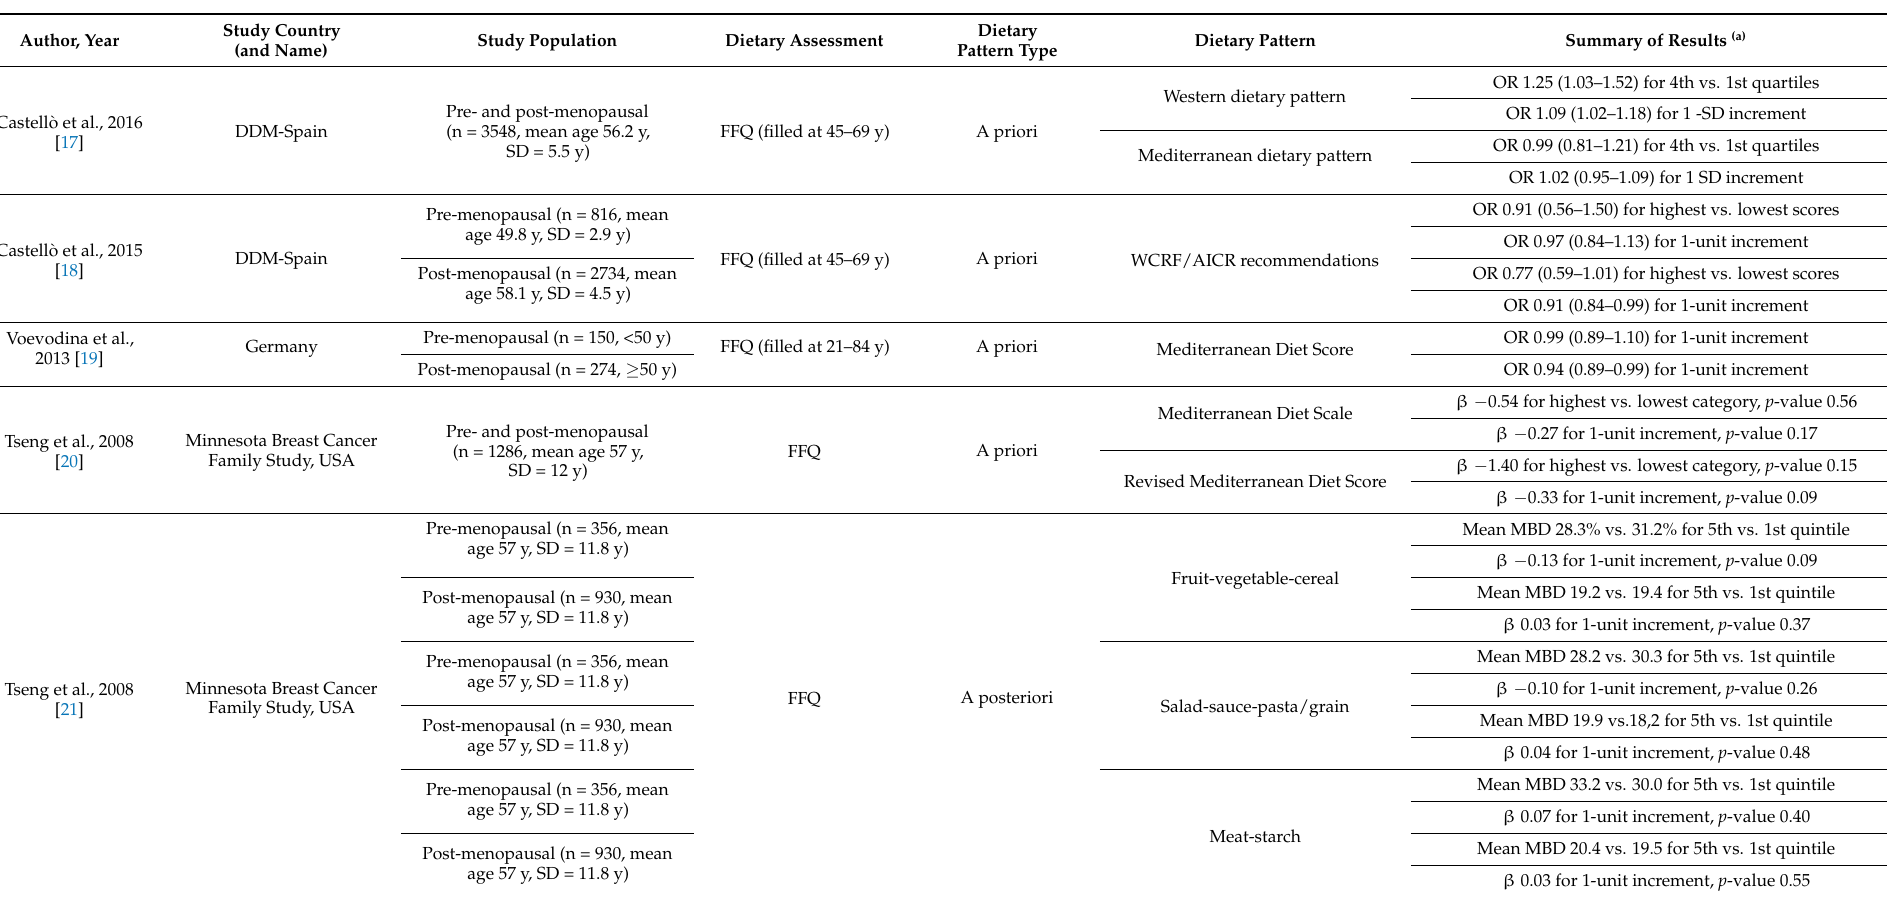
Table 1. Main characteristics and results (for the whole study group or stratified by menopausal status when available) of cross-sectional studies reporting on the association between a-priori- or a-posteriori-defined dietary patterns and mammographic breast